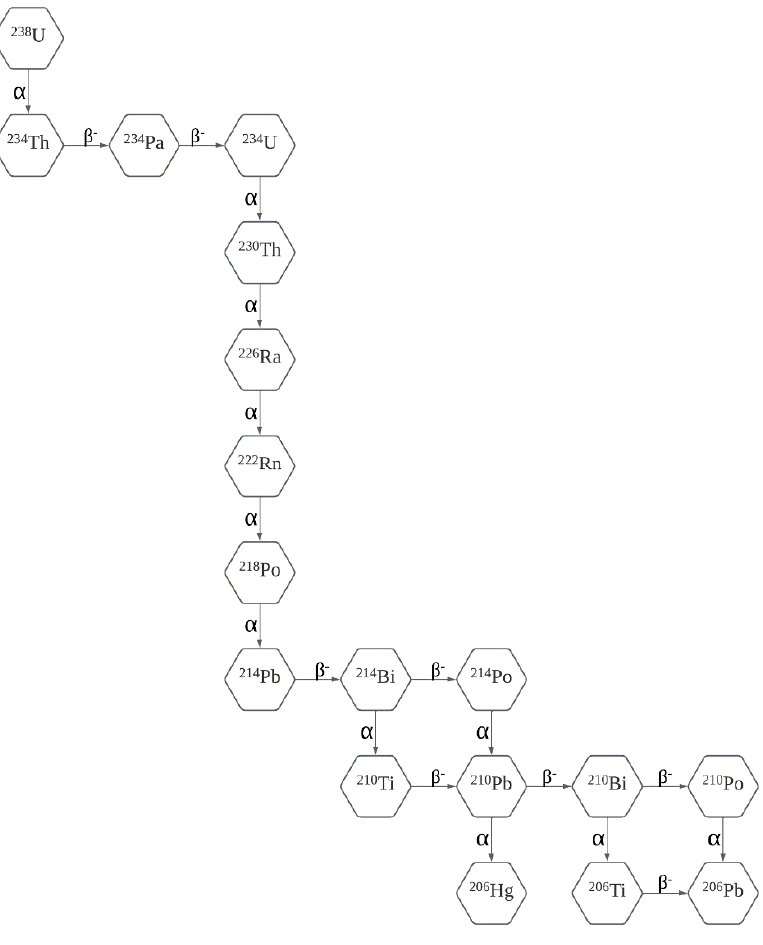
Figure 2. Uranium decay sequence and the radon progeny (adapted from [23–25]).